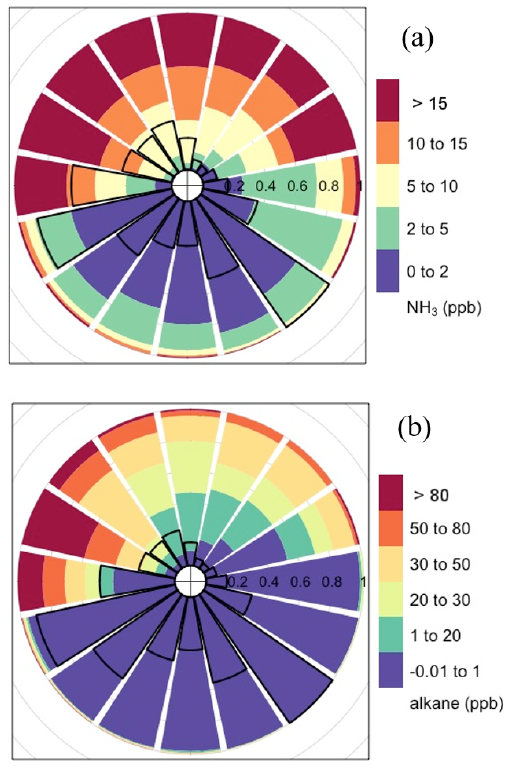
Figure 3. Normalized rose plot of NH 3 (a) and total alkane (b) mole fractions from FTIR bottom path. Colors represent the mole fraction in part per billion. The length of each colored segment presents the time fractions of that mole fraction range in each direction bin. The radius of the black open sectors indicates the frequency of wind in each direction bin; the angle represents wind direction – straight up is north and straight left is